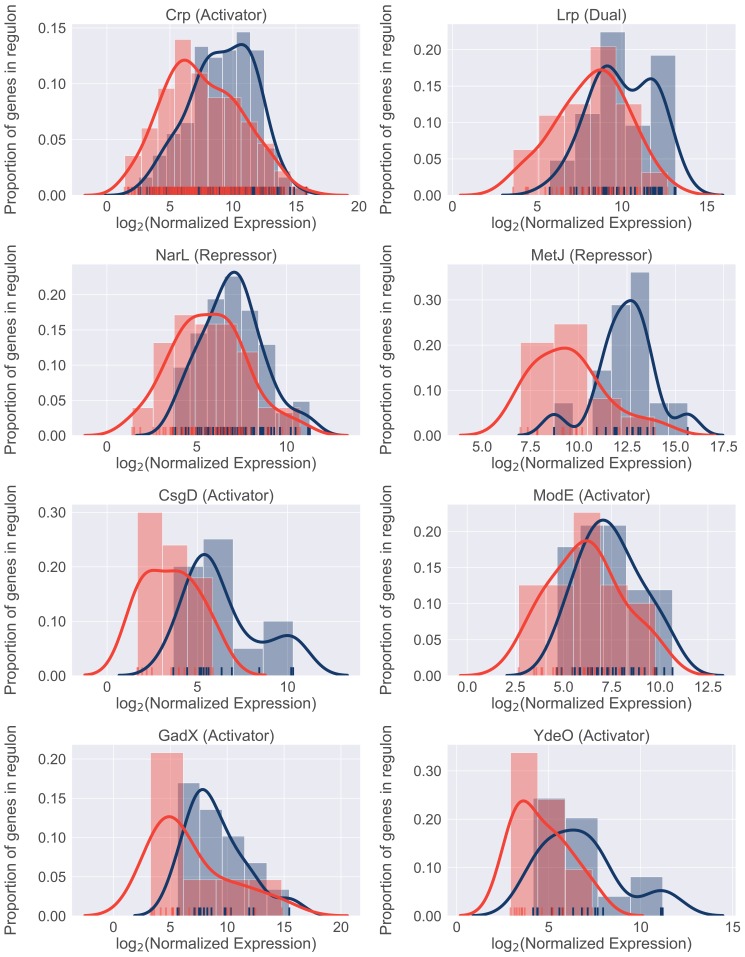
Differential regulon expression suggests role for multiple regulators in resource reallocation.Regulon expression for 8 out of 22 regulons enriched for genes downregulated in the patients. Expression of each gene in the regulon during in vitro culture (blue) or during UTI (red) is shown along the x-axis. Histograms show proportion of genes in the regulon expressed at any given level.